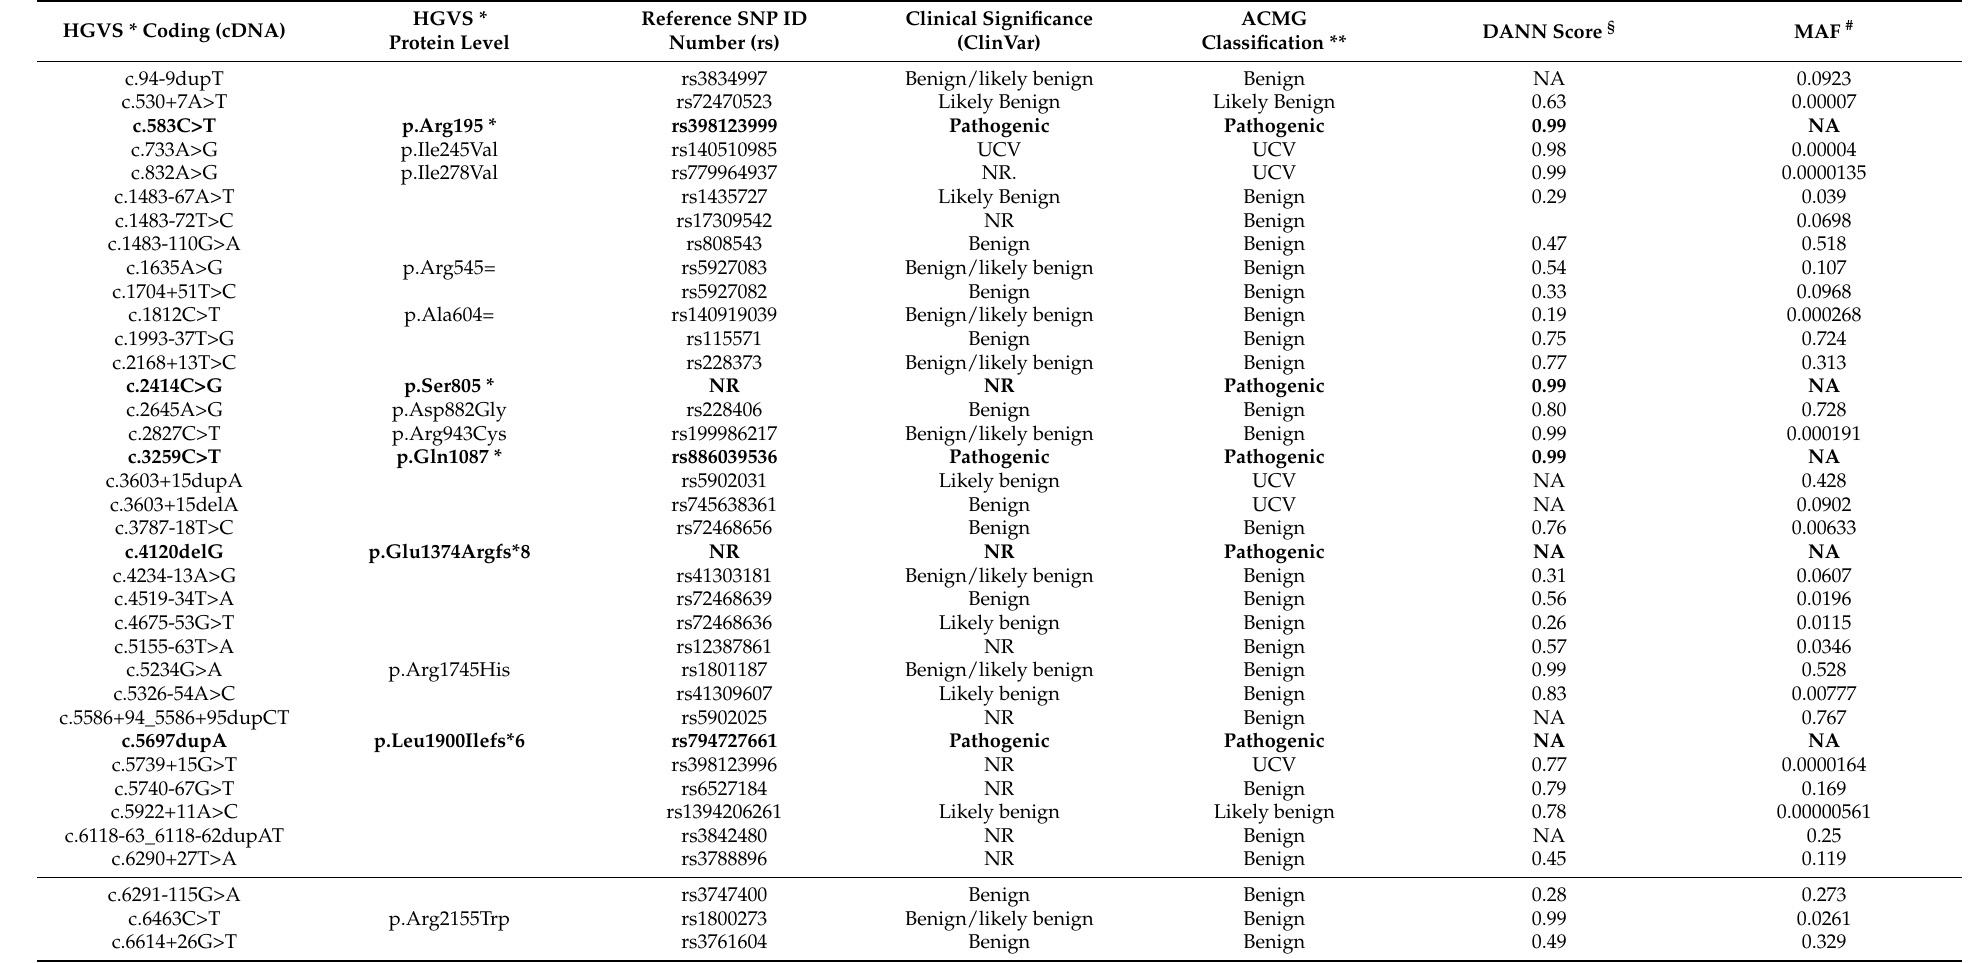
Table 1. DMD small nucleotide variants identified by NGS in the 40 analyzed subjects. Fifty-eight variants were identified in total, of which five pathogenic mutations (in bold) were identified in one study subject, as reported in Table